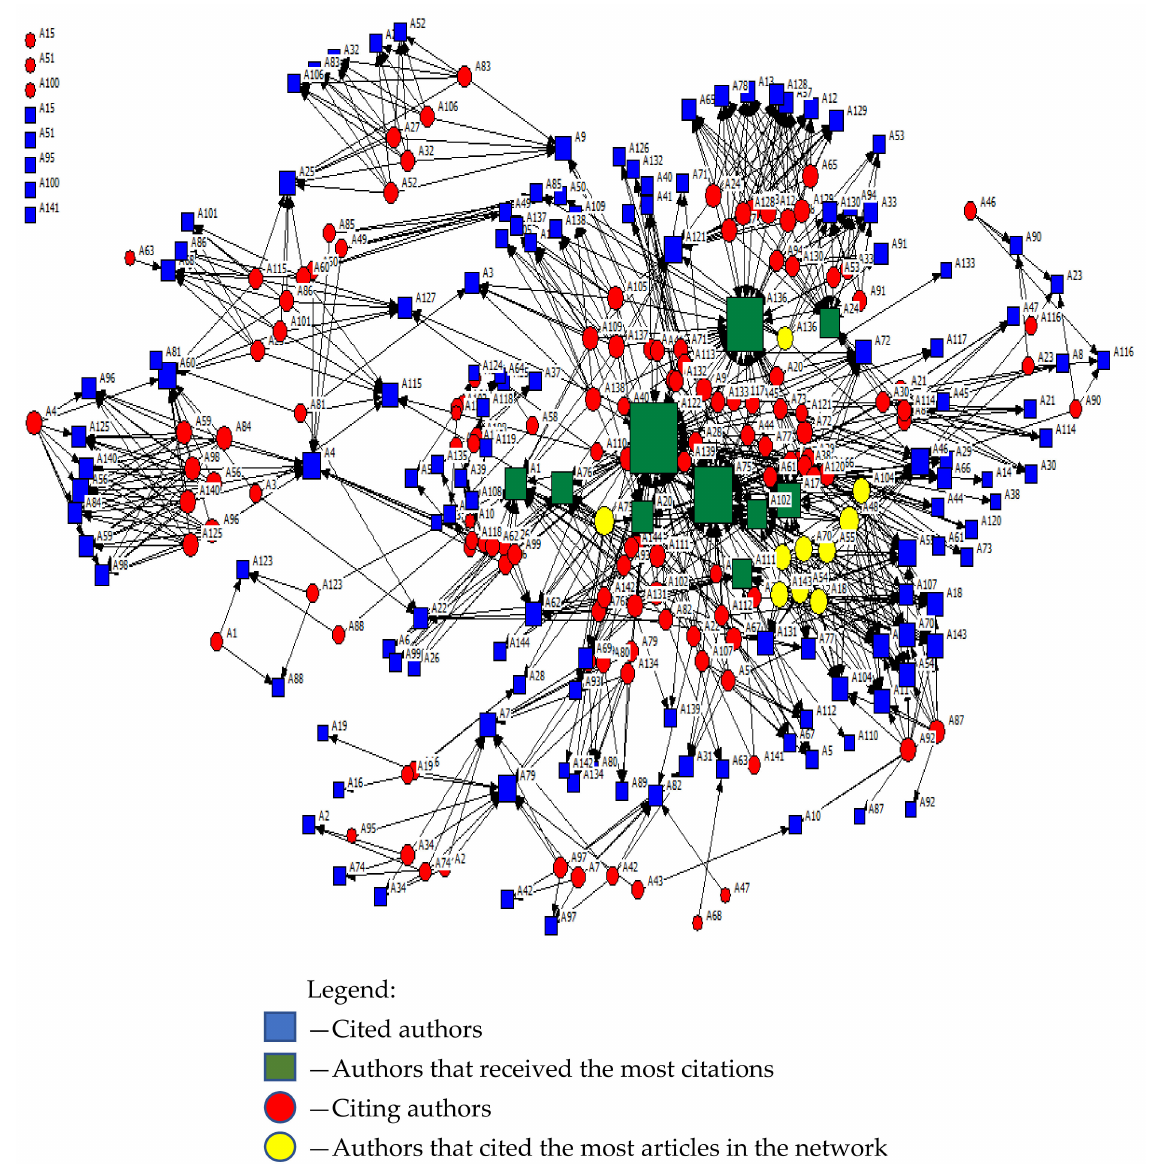
Figure 4. Citation map among